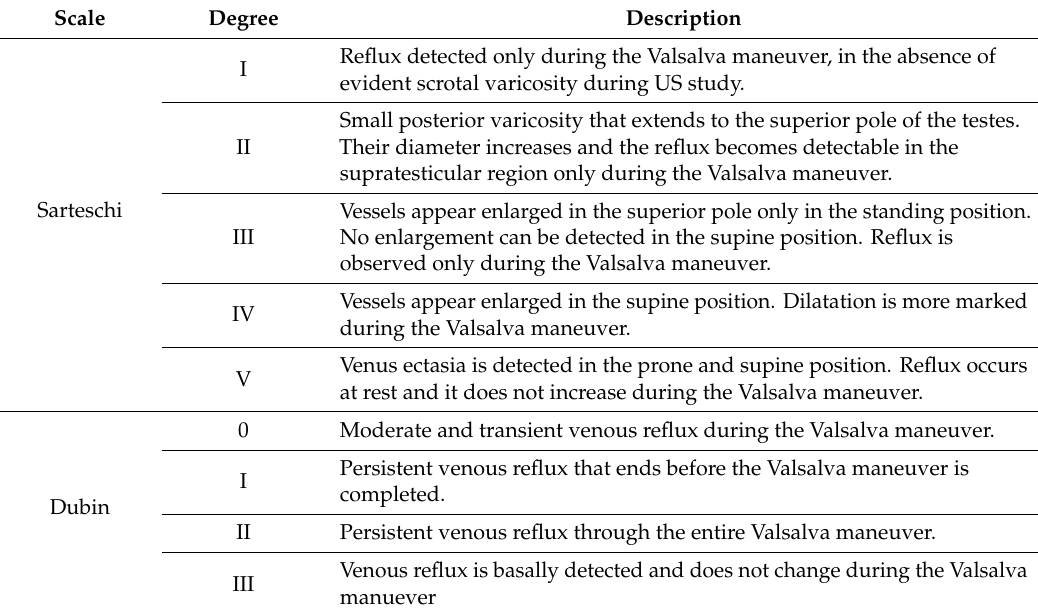
Table 1. Ultrasound varicocele degree